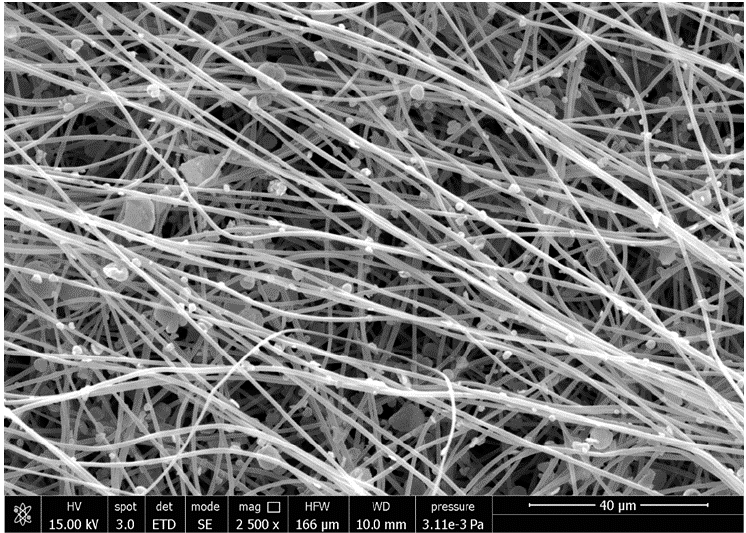
Figure 6. Representative SEM micrograph (2500×) of electrospun pullulan mesh impregnated with CLA, visible as microparticles attached to the fibers. [CLA stands for CN-NL-GA]. Scale bar is 40 microns.